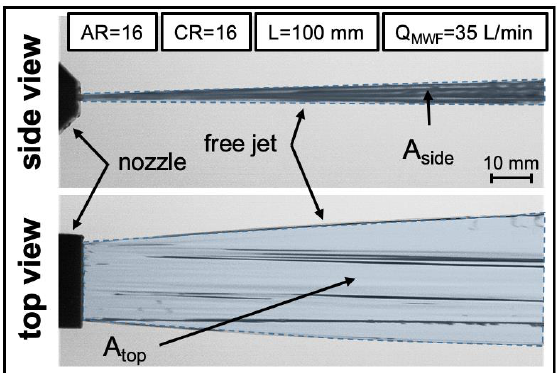
Figure 7. Shadowgraphy of the free jet in side view and top view.